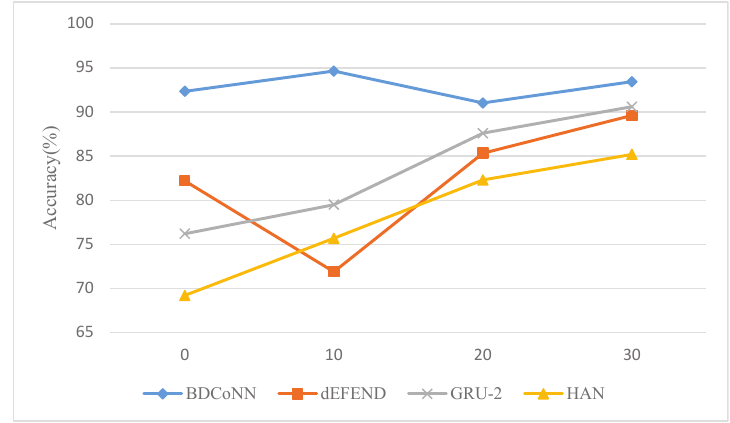
Figure 6. Accuracy of CED’s early rumor